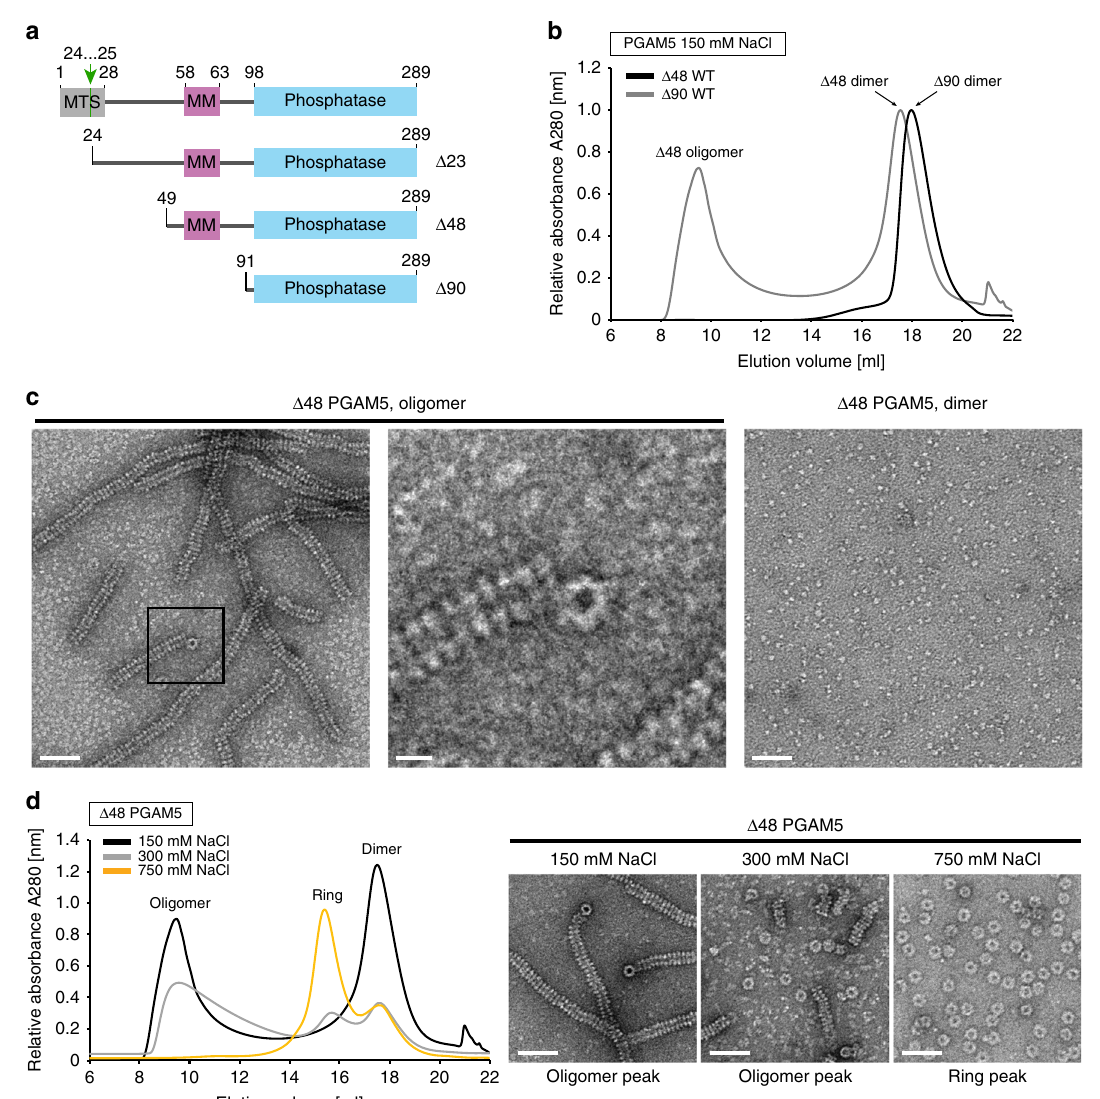
Fig. 1 Δ 48 PGAM5 forms tubular fi laments in solution composed of ring-like structures. a Domain architecture of constructs used in this study. Full-length PGAM5 is comprised of a single transmembrane helix containing a mitochondrial targeting sequence (MTS), a linker domain including the regulatory multimerization motif (MM), and a C-terminal PGAM phosphatase domain. The native cleavage site between residues 24 and 25, cleaved by PARL 6 , is marked with a green arrow. b Elution pro fi les for Δ 48 and Δ 90 PGAM5 constructs puri fi ed by size exclusion chromatography (SEC) using a Superose 6 column (GE Healthcare) in SEC buffer containing 20 mM Tris-Cl pH 8.0, 500 µ M TCEP, and 150 mM NaCl. The corresponding oligomeric states of